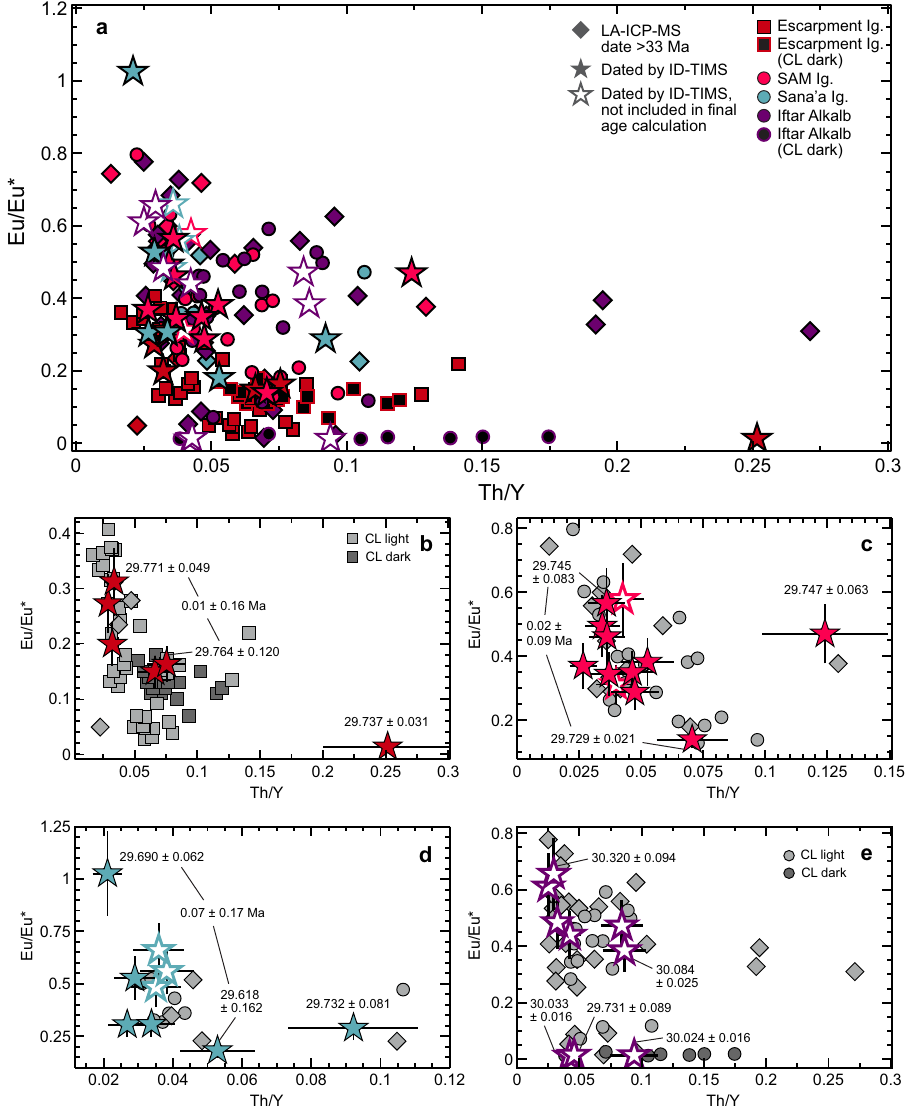
Fig. 4 Composition of zircon from the Escarpment, SAM, and Sana ʼ a Ignimbrites and Iftar Alkalb. a Zircon crystals are denoted by age, dating method, and inclusion in fi nal age calculations. Zircons >33Ma (from preliminary LA-ICP-MS dating, average 2 σ uncertainty ±3Ma) are denoted by diamond symbols. Non-luminescent (CL-dark) zircon crystals from the Escarpment Ignimbrite and Iftar Alkalb are denoted by black symbols. a – e show Th/Y versus Eu/Eu* in detail for the Escarpment Ignimbrite ( b ), SAM Ignimbrite ( c ), Sana ’ a Ignimbrite ( d ), and Iftar Alkalb ( e ). Error bars in b – e are 2 σ (Supplementary